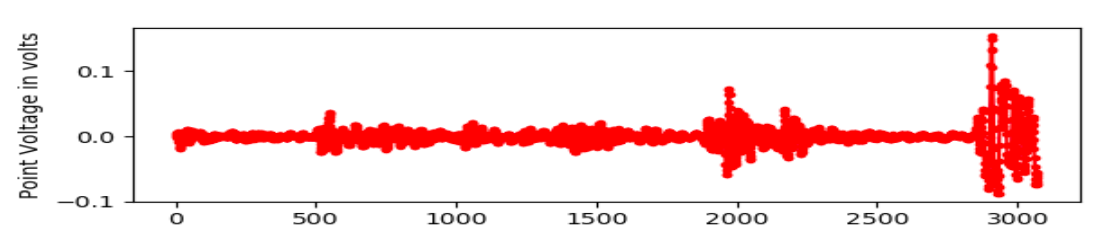
Figure 3. Visualization of the AE signal numbered 3280 emitted from tube #1 .